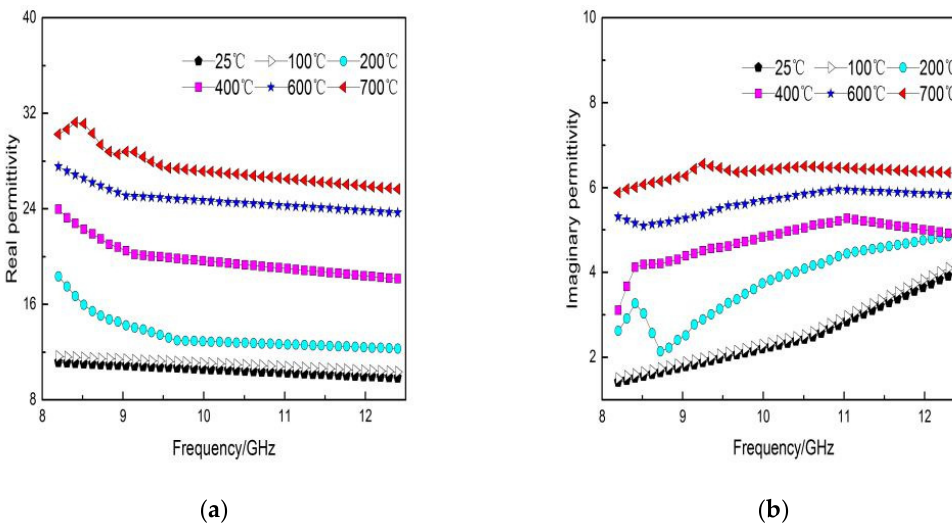
Figure 7. Dielectric properties of the Al 2 O 3 –MoSi 2 /Cu composite coating: ( a ) ε ′ of the Al 2 O 3 –MoSi 2 /Cu composite coating; ( b ) ε ″ of the Al 2 O 3 –MoSi 2 /Cu composite coating.